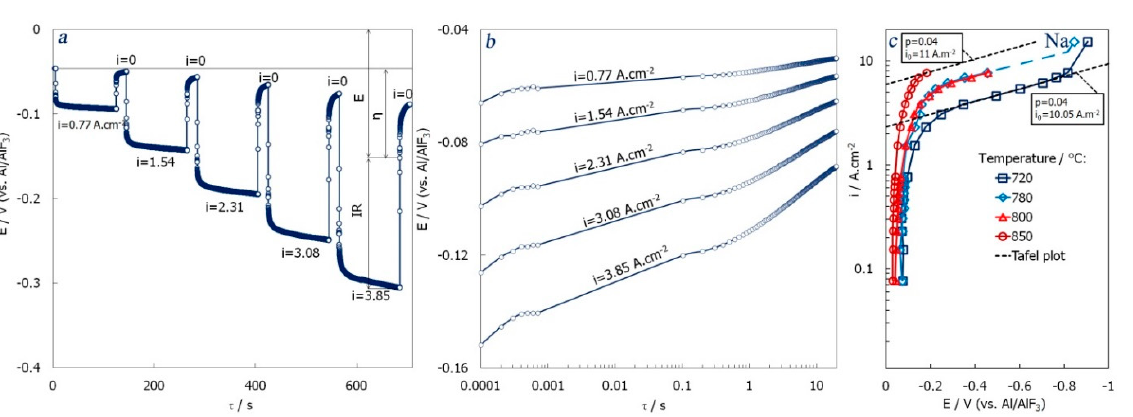
Figure 2. Schematic representation of a multiple-capillary cell: 1—PGSTAT Autolab 302n with